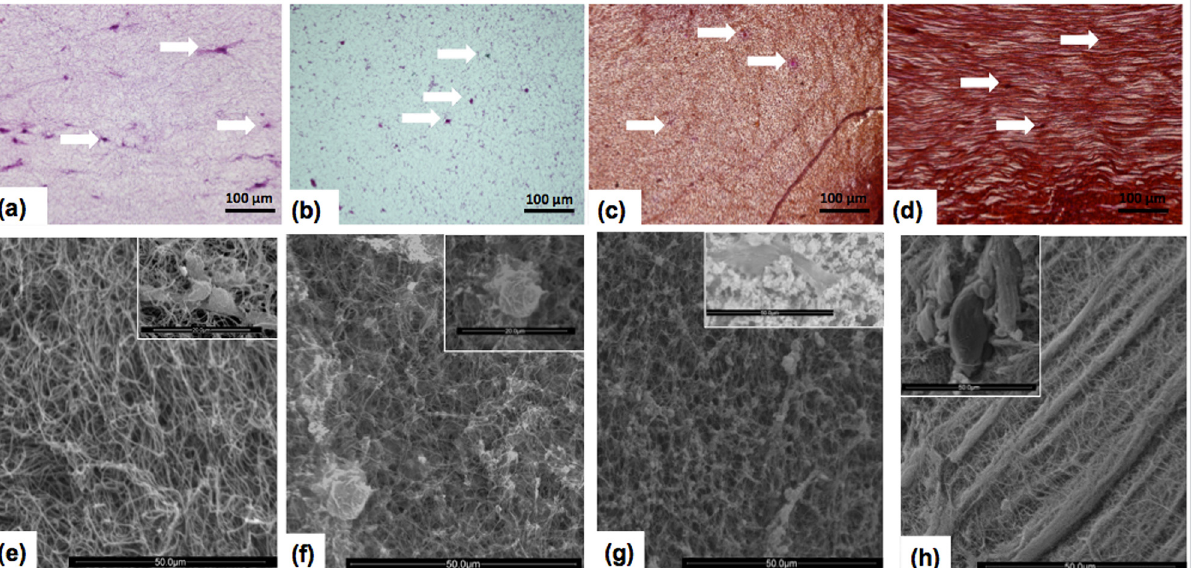
Fig 1. Microscopic images of tissue substitutes. 1a-1d: Light microscopy. 1e-1h: Scanning electron micrographs with individual cells shown in the insets. 1a and 1e: control (nonmagnetic) samples gelled in the absence of a magnetic field (Ctrl-MF0). 1b and 1f: control (nonmagnetic) samples with nonmagnetic polymer particles (Ctrl-NP). 1c and 1g: magnetic samples gelled in the absence of a magnetic field (M-MF0). 1d and 1h: magnetic samples gelled during application of a magnetic field (32 kA/m in 1d, and 48 kA/m in 1h). A few of the cells are marked with arrows in Fig 1a to 1d. Scale bars: Fig 1a-1d, 100 μ m; Fig 1e-1h, 50 μ m including insets, except for insets in Fig 1e and 1f, 20 μ